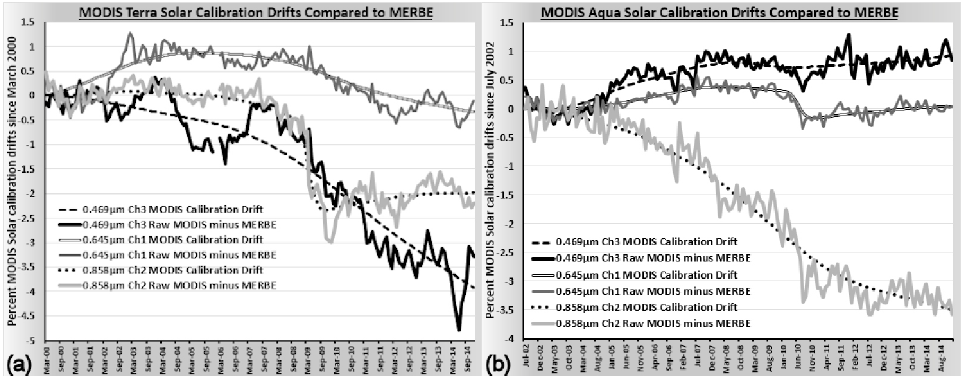
Figure 3. ( a ) MERBE Estimates of Terra MODIS Ch 1–3 calibration drifts; ( b ) MERBE Estimates of Aqua MODIS Ch 1–3 calibration drifts (both from the start of